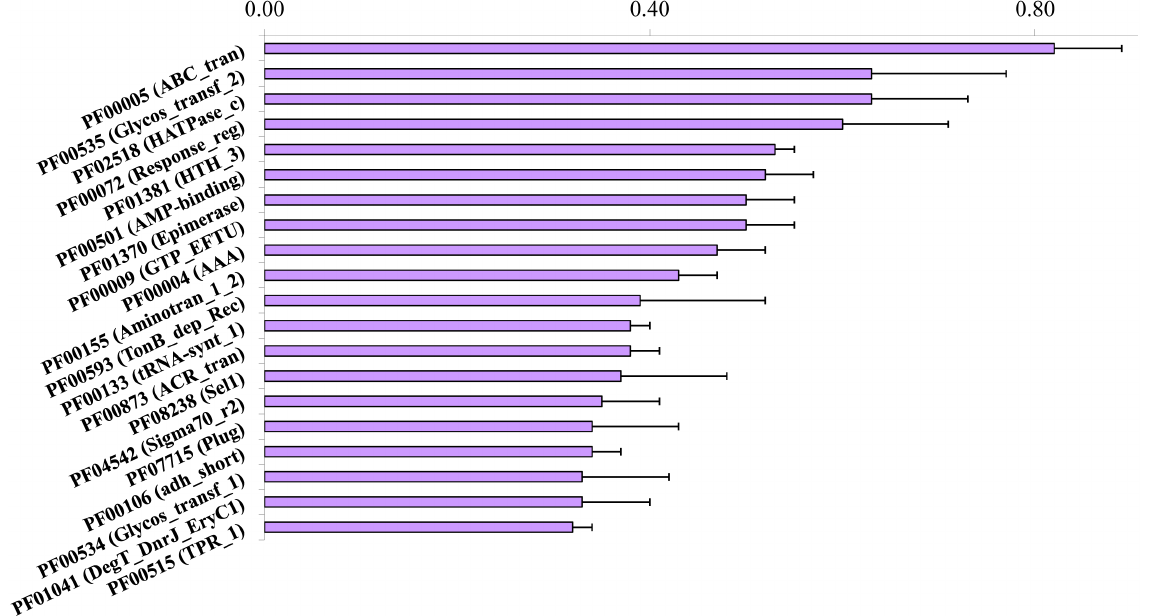
Figure 2. The 20 most common Pfam protein families in the ovine rumen microbiome. Error bars represent SD ( N =5). X-axis: relative abundance